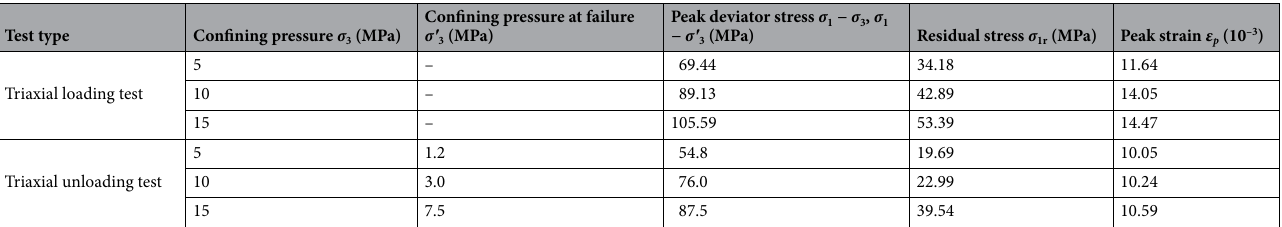
Table 1. Triaxial loading and unloading test results.